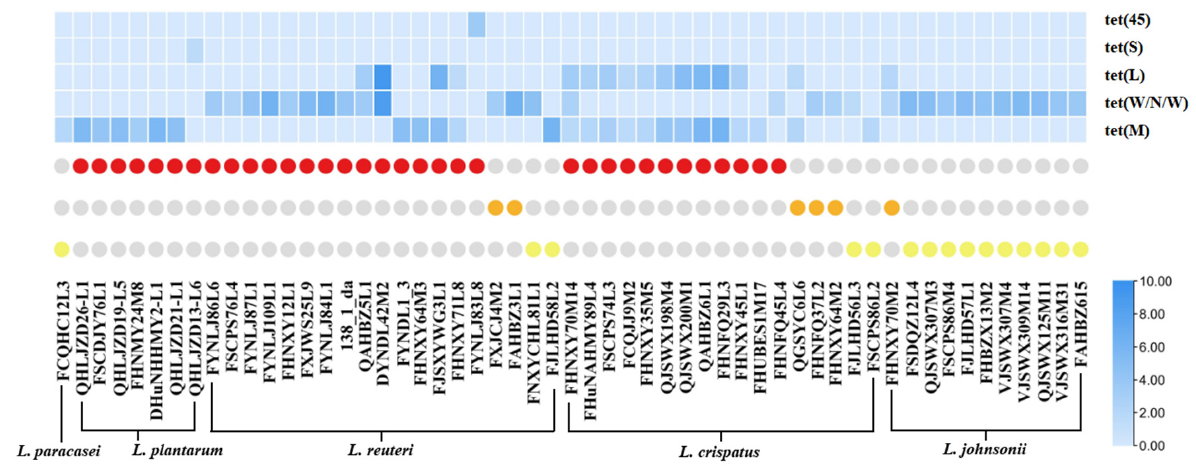
Figure 4. The expression of resistance genes in phenotypically resistant strains induced by tetracycline at the concentration of 1/2 × MIC. The heatmap above represents the level of gene expression. The circle chart represents the MIC for the strain, the red circle indicates that the MIC for the corresponding strain is greater than 128 µ g/mL, the orange circle indicates that the MIC for the corresponding strain is equal to 128 µ g/mL, and the yellow circle indicates that the MIC for the corresponding strain is equal to 64 µ g/mL.